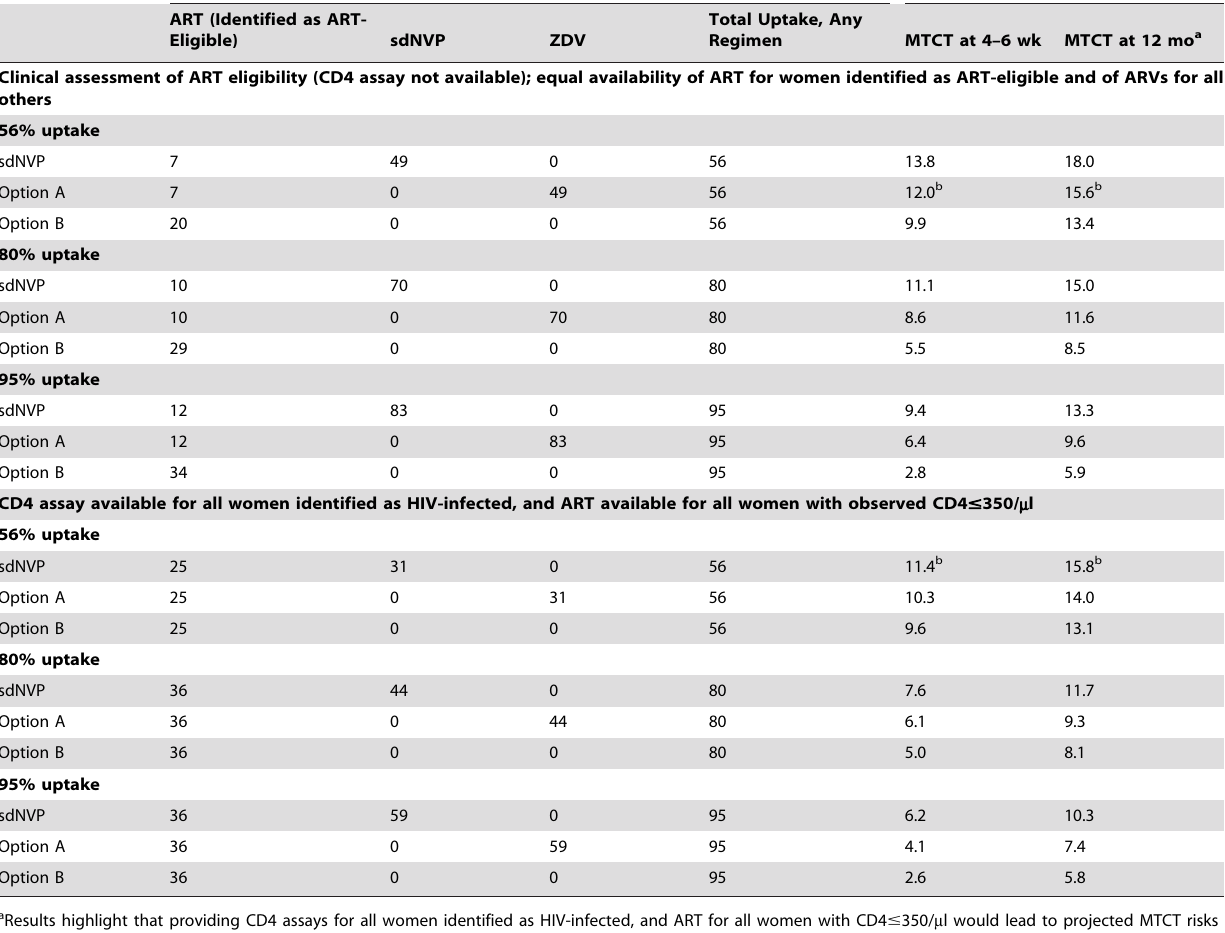
Table 8. Impact of availability of CD4 assays and ART for women with CD4 # 350/ m l.